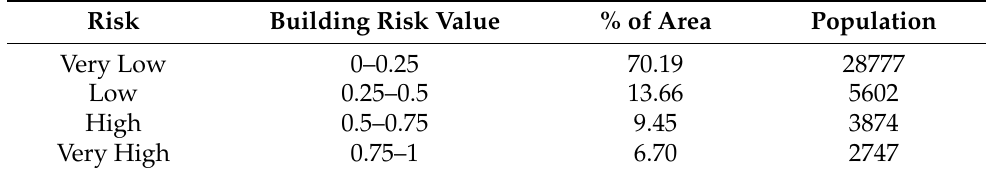
Figure 20. A small study area of Dzaleka Refugee Camp through building analysis processing: ( a ) buildings classified as thatched or tin; ( b ) building risk map created by combining building classifications (Figure 20a) and the comprehensive flood model (Figure 16f). Table 3. Percentage of area covered for each risk category, along with the approximate population living